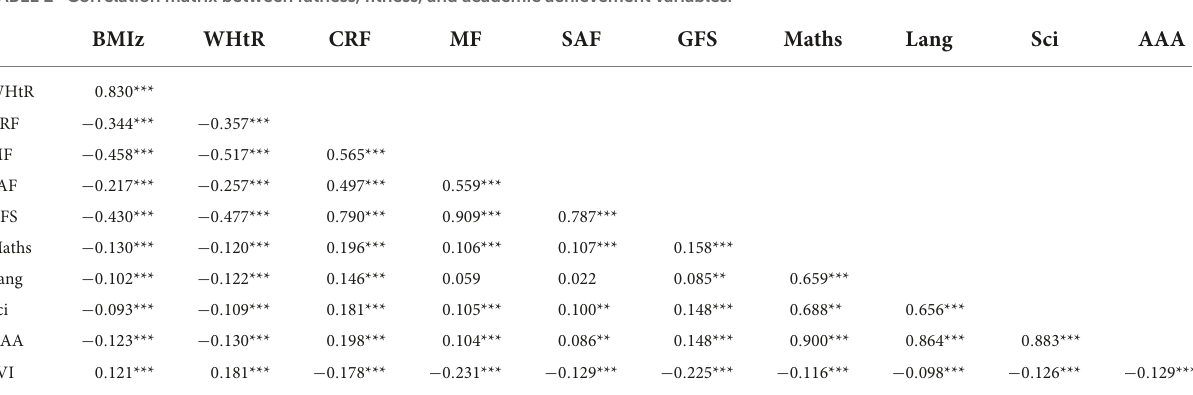
TABLE 2 Correlation matrix between fatness, fitness, and academic achievement